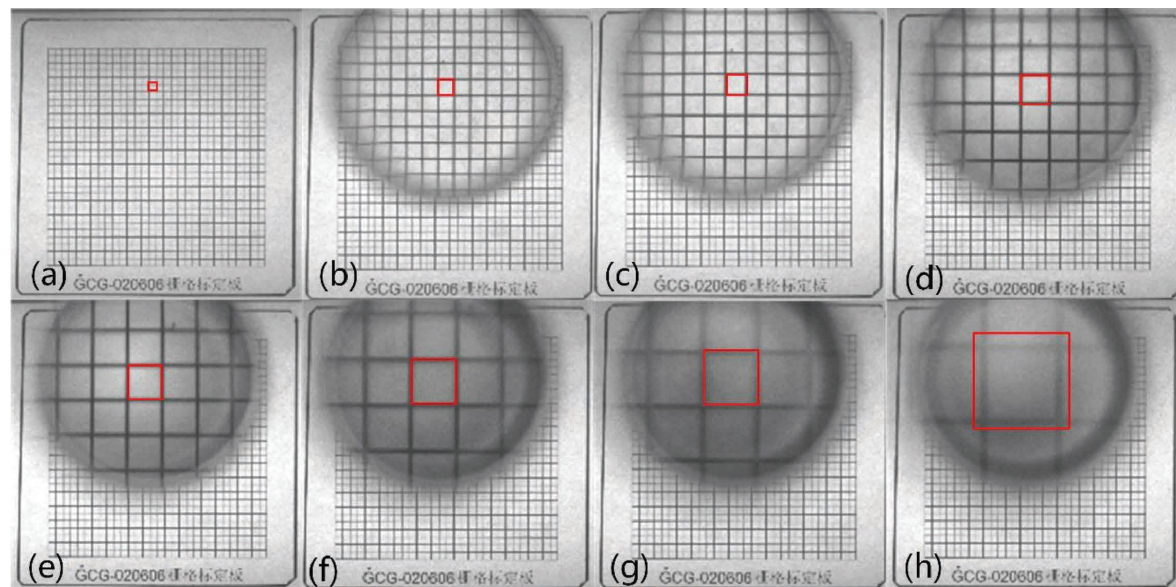
Figure 8: Grid calibration chart imaging results. (a) 16 mm focal length peripheral channel imaging without foveated zoom